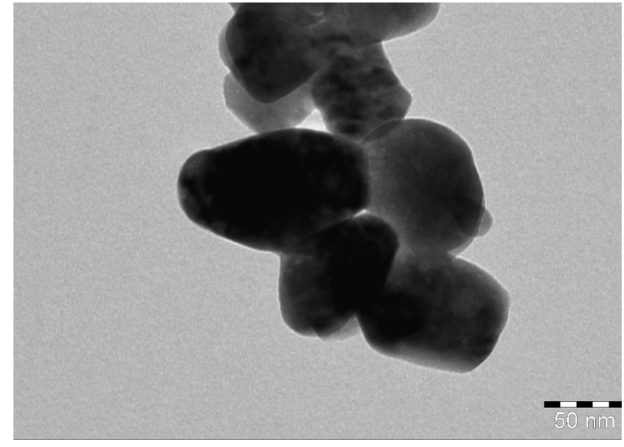
Figure 3. TEM micrograph of biosynthesized ZnO NPs.